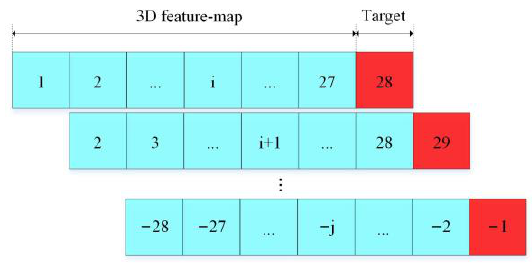
Figure 8. Definition of classification